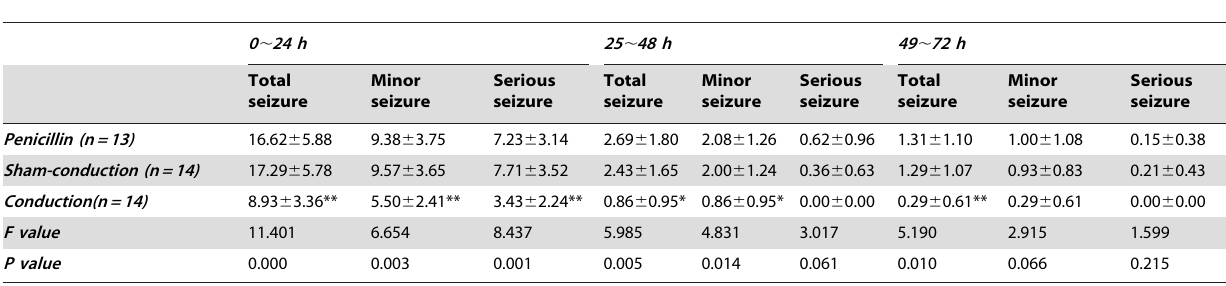
Table 2. Frequency of behavioral seizures in neocortical epilepsy model (mean 6